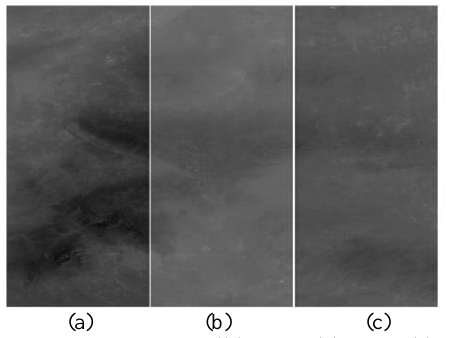
Figure 6 . Comparison of attitude results of CCD3